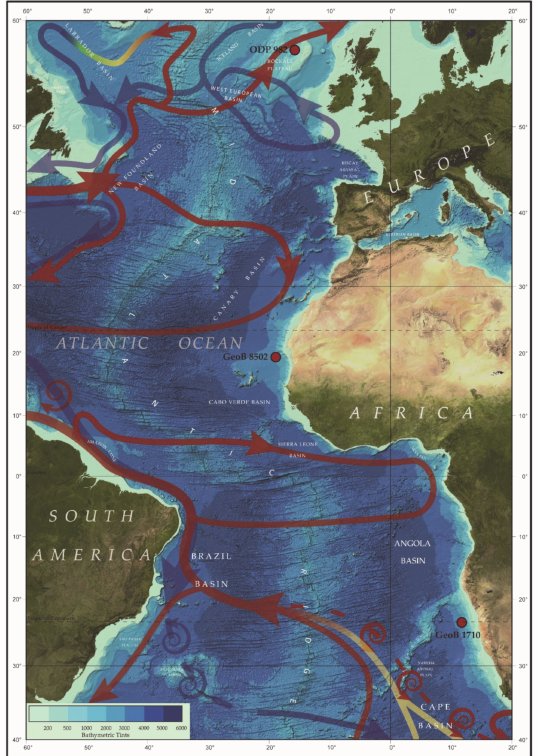
Figure 1. Location of the sediment cores and schematic of the Atlantic Meridional Overturning Circulation. Red is the surface flow, blue the deep one, and yellow and green represent transition flows between depths. Terrain after the general bathymetric chart of the Ocean. GeoB 8502 (19 ◦ 13.27’ N, 18 ◦ 56.04’ W) is a Tropical North Atlantic pelagic site at